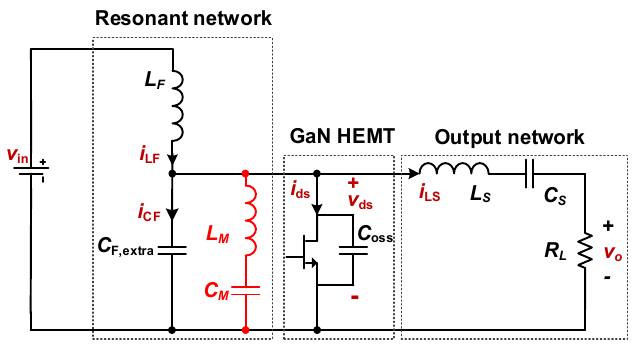
Figure 1. Topology of a VHF class Ф 2 inverter.